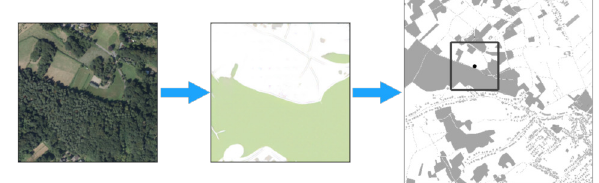
Figure 1. Method Overview: First, an aerial image is collected, then it is segmented into a map-like representation, finally it is matched within a reference map for localization of the